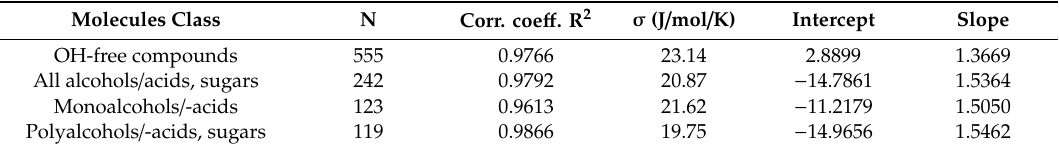
Table 14. Statistics of the correlations between molecular volumes and solid heat capacities at